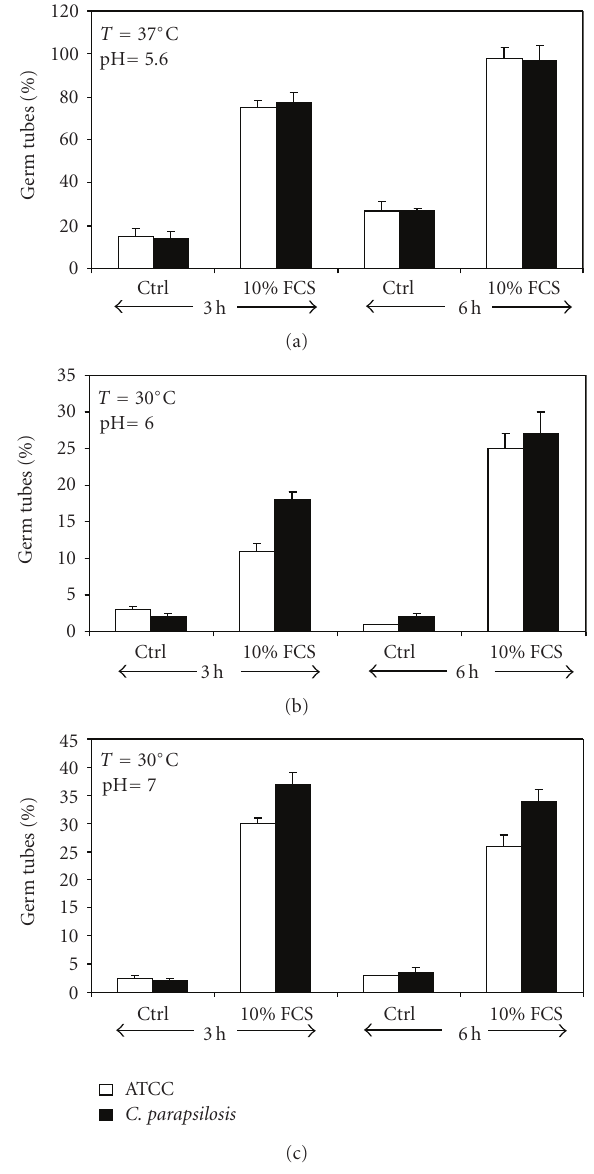
Figure 2: Blastospore-to-hyphal transition of C. parapsilosis . Following culture at di ff erent temperatures and neutral pH with or without proteins (serum), the percentage of C. parapsilosis germ tubes was determined by dividing the number of hyphae over the total number of cells (blastospore and hyphae) in each culture condition. The mean relative values for six separate experiments are shown. C. albicans was used as a reference strain to C. parapsilosis